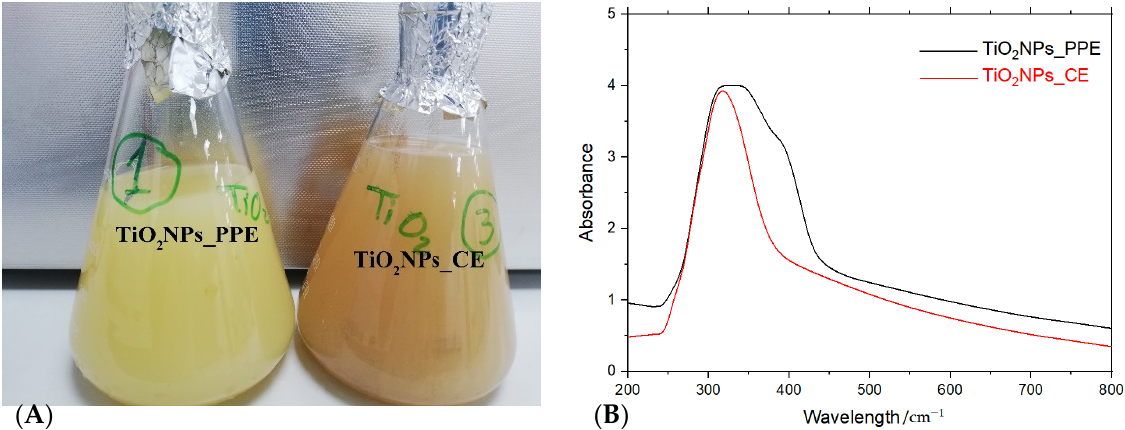
Figure 1. Green synthesis of titanium dioxide nanoparticles using pomegranate peel extract (PPE), and coffee ground extract (CE). ( A ). Change in color of the reaction to cloudy yellow and brown after the production of nanoparticles. ( B ). UV − Visible spectral analysis of green-synthesized titanium dioxide nanoparticles TiO 2 NPs_PPE and TiO 2 NPs_CE.